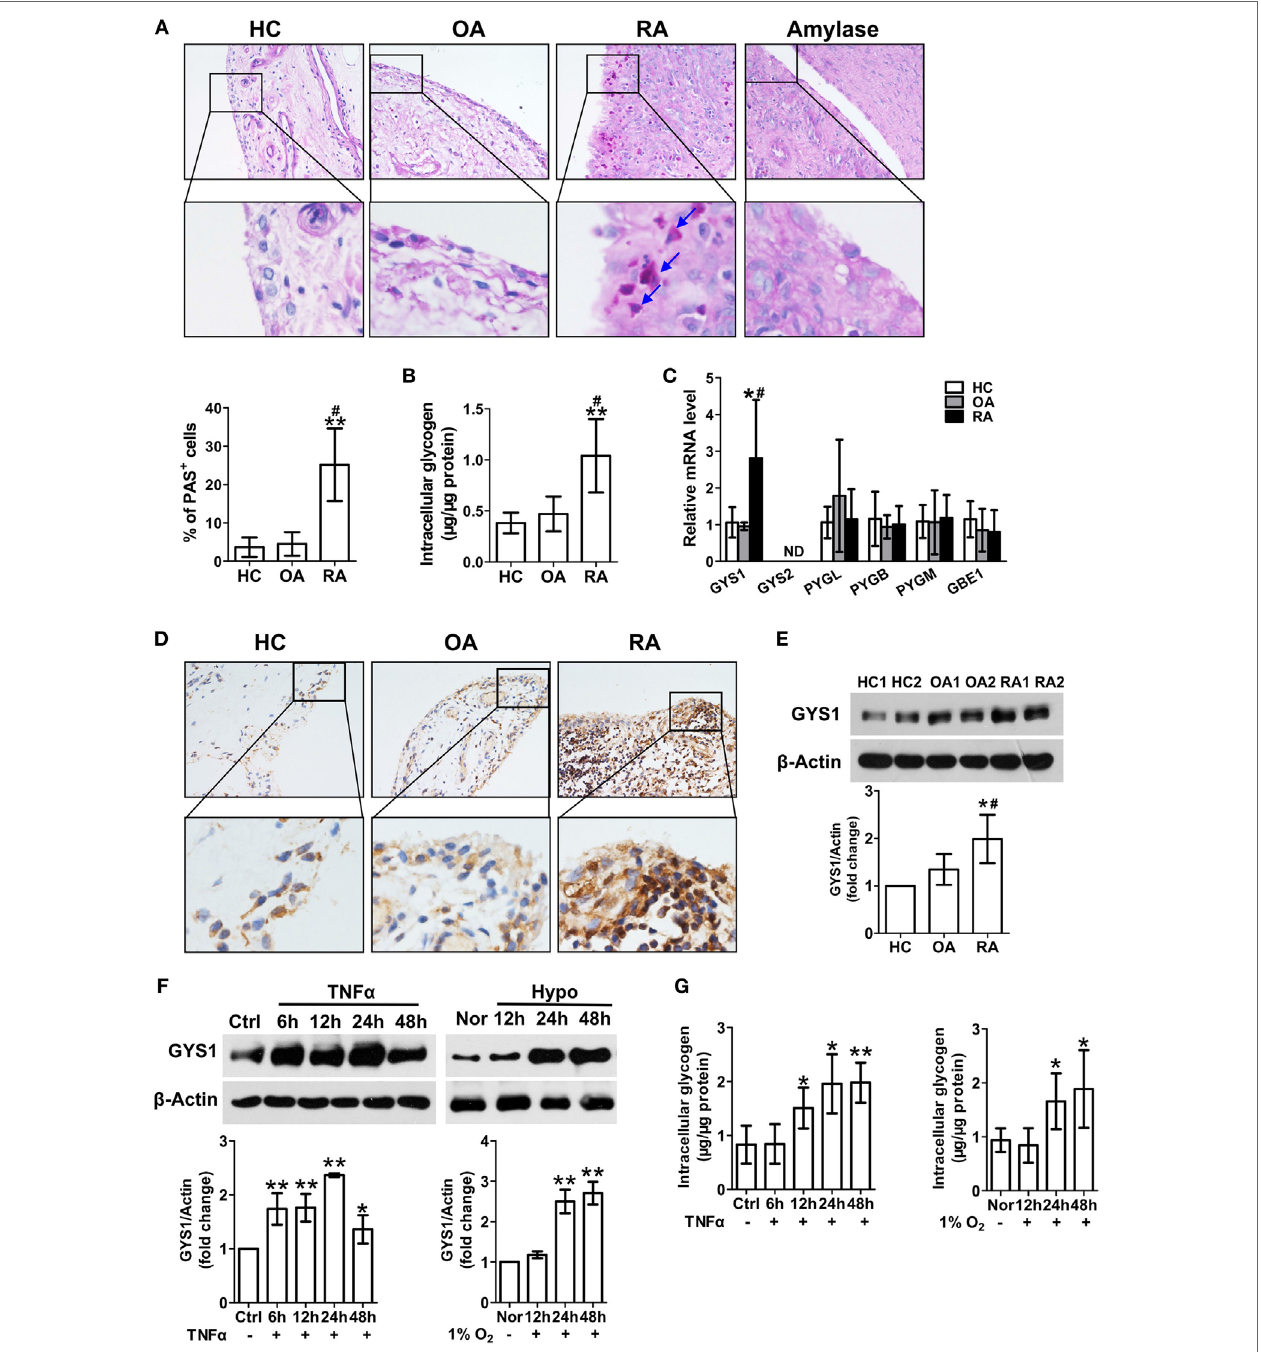
FigUre 1 | Increased glycogen synthase 1 (GYS1)-mediated glycogen synthesis in synovial tissue (ST) and fibroblast-like synoviocytes (FLSs) from rheumatoid arthritis (RA) patients. (a) Glycogen levels in STs from patients with healthy controls (HCs), osteoarthritis (OA), RA, confirmed to be glycogen by the absence of staining after amylase pretreatment. Representative images (upper panel) and semi-quantitative chart (lower panel) of periodic acid Schiff (PAS) staining for ST sections from HC ( n = 5) and patients with OA ( n = 6) and RA ( n = 10). (B) Glycogen content in FLSs from HC ( n = 5) and patients with OA (n = 6) and RA ( n = 11). (c) Detection of glycogen metabolism-related gene transcripts by quantitative real-time PCR in FLSs from HC ( n = 5) and patients with OA ( n = 8) and RA ( n = 12). (D) GYS1 protein expression in STs. Representative images of immunohistochemical staining of tissues from HC ( n = 5) and patients with OA ( n = 6) and RA ( n = 8). Original magnification 200 × . (e) GYS1 protein expression in FLSs. Representative images of immune blot (upper panel) and densitometric quantification (mean ± SD, lower panel) of GYS1 expression were from HC ( n = 5) and patients with OA ( n = 6) and RA ( n = 12). (F,g) FLSs were exposed to TNF- α (10 ng/ml) or hypoxia (hypo, 1% O 2 ). GYS1 expression (F) was detected by Western blot. The densitometric quantification [lower panel of (F) ] of immune blot and glycogen levels (g) is presented as the mean ± SD of four independent experiments. * P < 0.05, ** P < 0.01 vs. HC or normoxia (nor) or Ctrl; # P < 0.05 vs. OA.